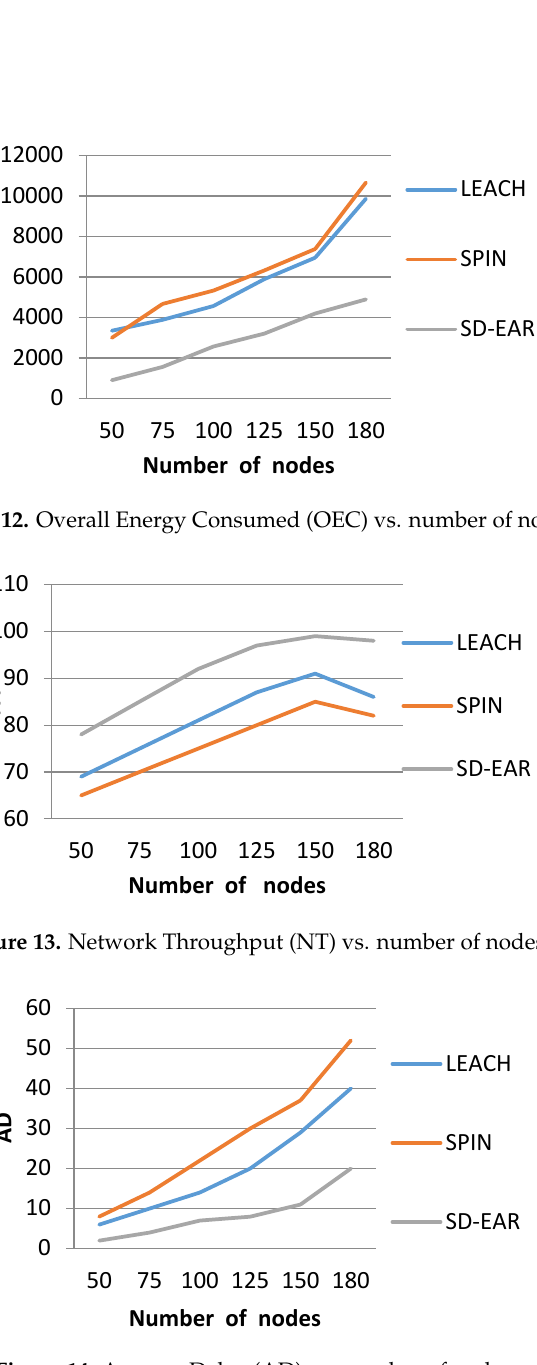
Figure 14. Average Delay (AD) vs. number of nodes.